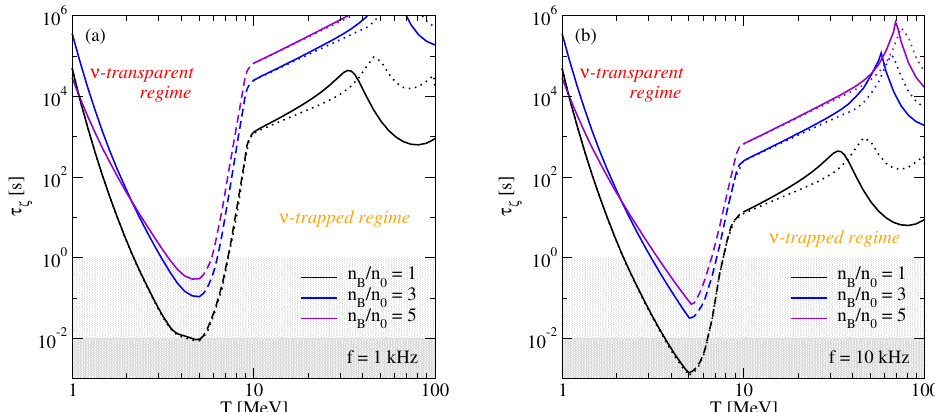
Figure 9. The oscillation damping timescale as a function of temperature for various densities for frequency fixed at ( a ) f = 1 kHz; ( b ) f = 10 kHz. The solid lines show the results obtained with isothermal, and the dotted lines—with adiabatic susceptibilities. The dashed lines interpolate between the results of neutrino-transparent and neutrino-trapped